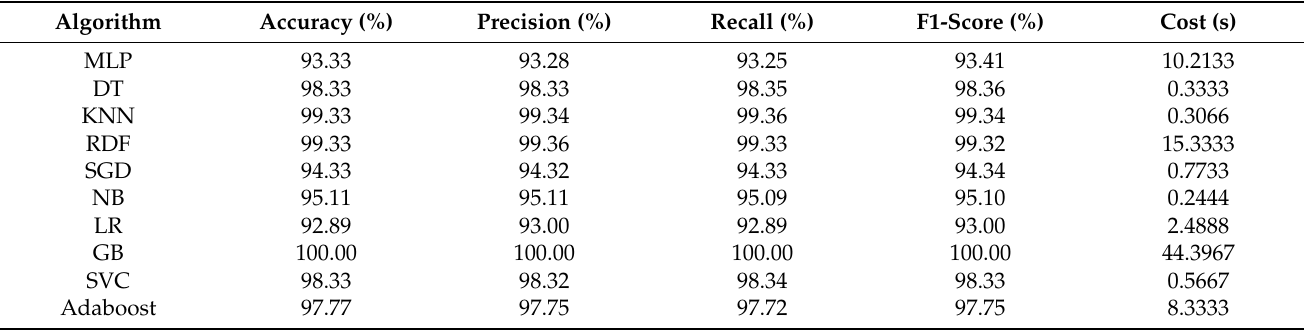
Table 8. Global performance comparison of ML models using (ESR)